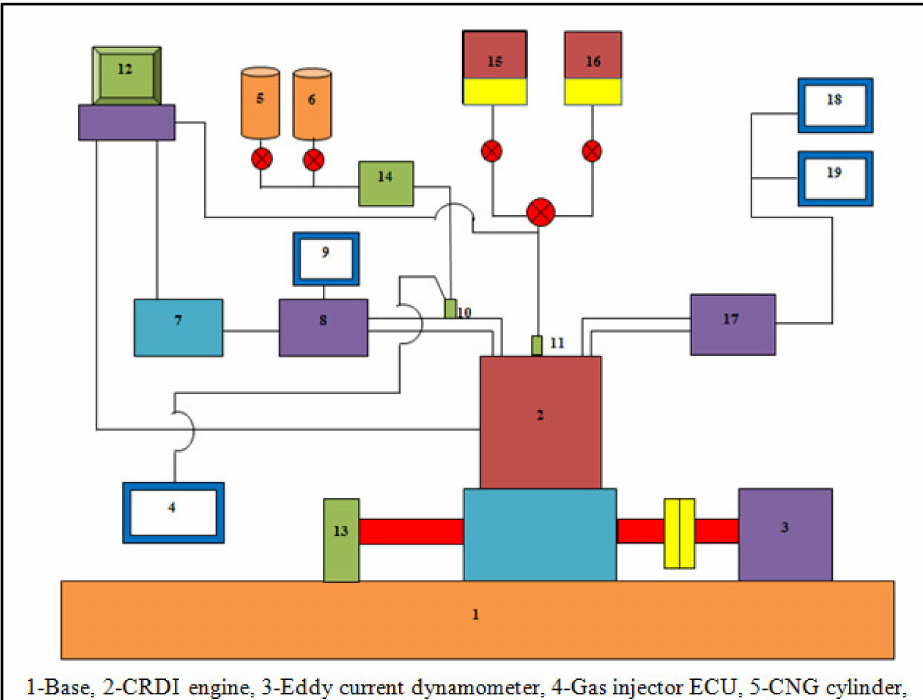
Figure 1. RCCI experimental